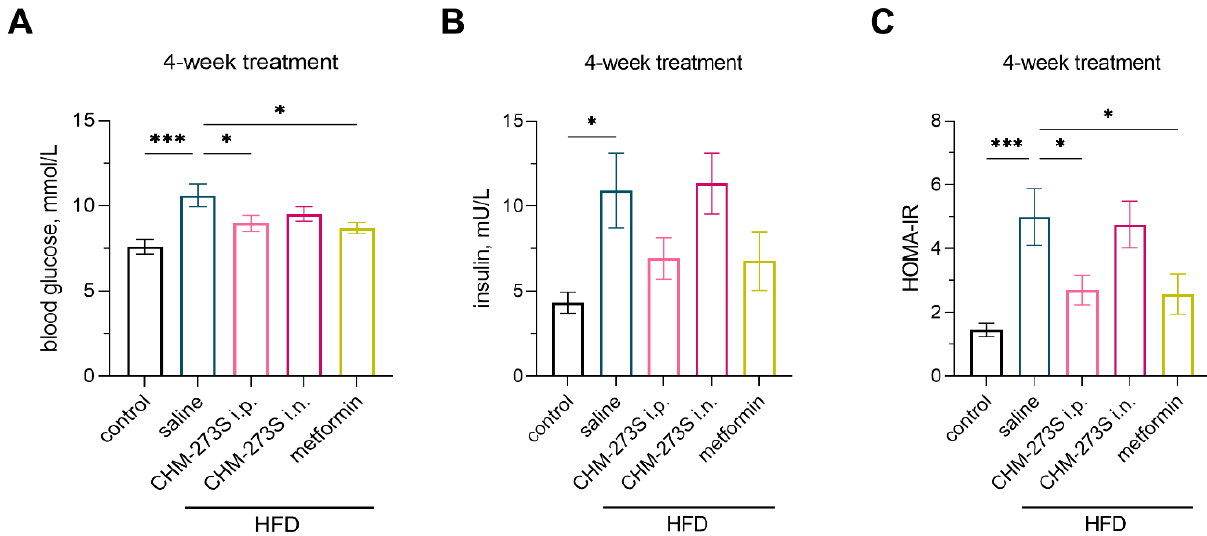
Figure 8. Fasting blood glucose, insulin, and homeostatic model assessment for insulin resistance (HOMA-IR) in high-fat diet (HFD)-fed mice treated for 4 weeks with CHM-273S (5 mg/kg intraperitoneally (i.p.) or intranasally (i.n.), n = 10 each) or metformin (250 mg/kg perorally (p.o.), n = 10). ( A ) CHM-273S i.p. and metformin significantly reduced blood glucose levels in comparison with HFD-fed, saline-treated animals (F (4,45) = 5.36, p = 0.0015). ( B ) Plasma insulin was significantly higher in HFD-fed mice ( n = 10) compared with control animals ( n = 10; F (4,45) = 3.58, p = 0.013), but neither CHM-273S nor metformin significantly reduced insulin levels compared with the HFD-fed, saline-treated group. ( C ) HOMA-IR was restored to the control values in HFD-fed mice when treated with i.p. CHM-273 or metformin (F (4,45) = 5.98, p = 0.0007). The results are presented as the mean ± standard error of the mean. * p < 0.05, *** p < 0.001, versus the HFD-fed, saline-treated group; one-way analysis of variance with the Holm –Šídák multiple comparisons test.